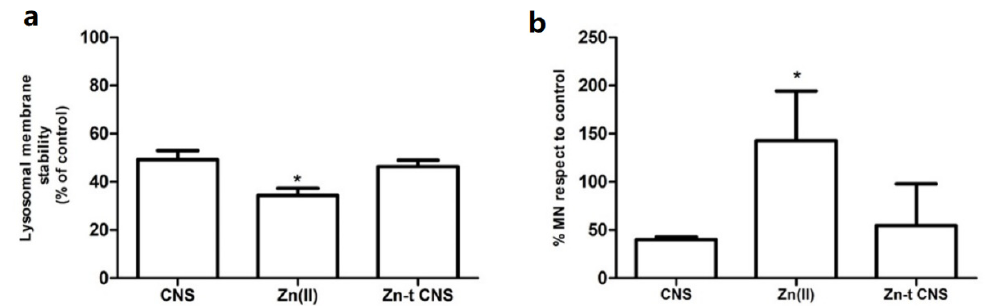
Figure 4. ( a ) Lysosomal membrane stability (LMS) shown as % vs. control (ASW) in mussel hemocytes at 30 min and ( b ) micronucleus frequency (MN) shown as % vs. control (ASW), after 48 h of exposure in the experimental groups: Zn(II) (10 mg L − 1 of ZnCl 2 in ASW); Zn-t CNS (ZnCl 2 10 mg L − 1 contaminated ASW treated with CNS); CNS (ASW treated with only CNS). Results are shown as % towards controls (mussels exposed to ASW only). (*) indicates significant difference with respect to the Zn(II) group ( p < 0.01).